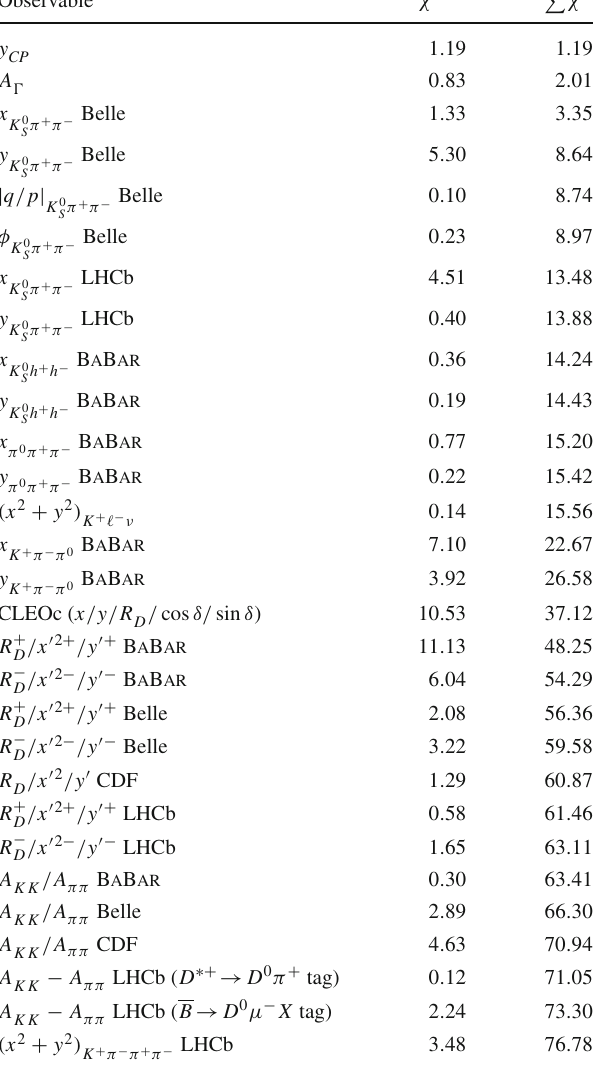
Table 263 Individual contributions to the χ 2 for the CPV -allowed fit Observable